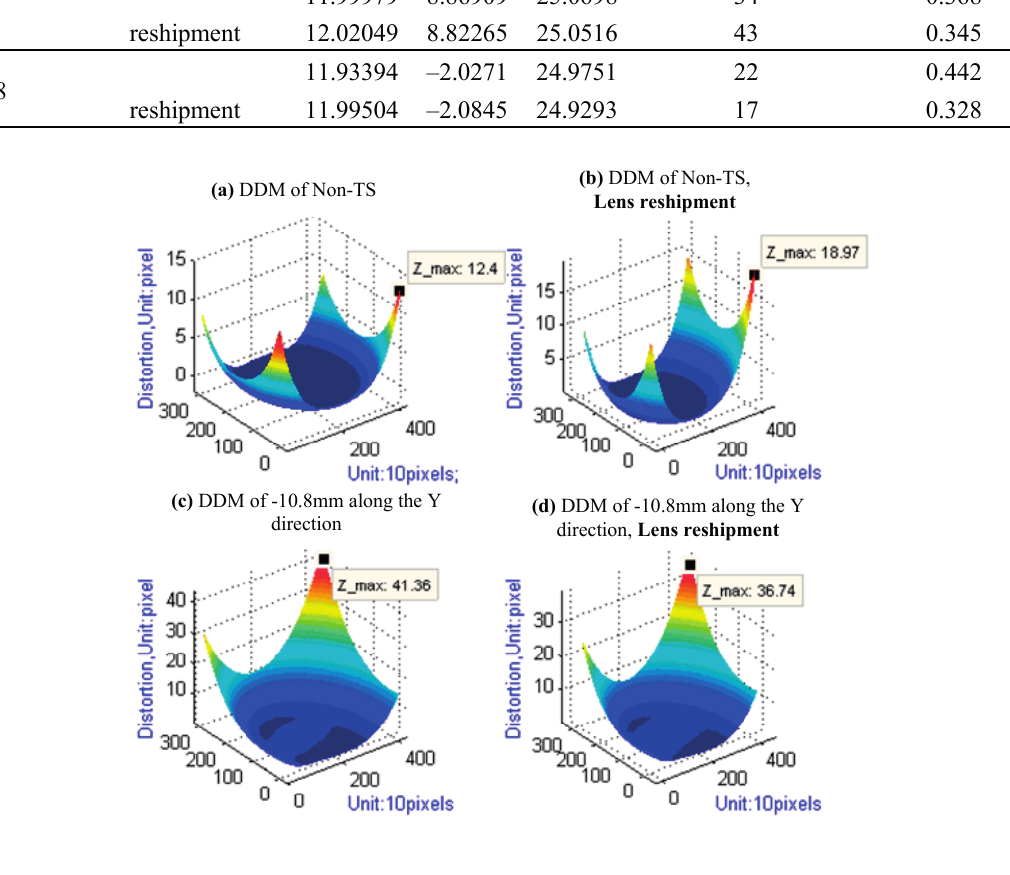
Figure 11. DDM of the lens reshipment